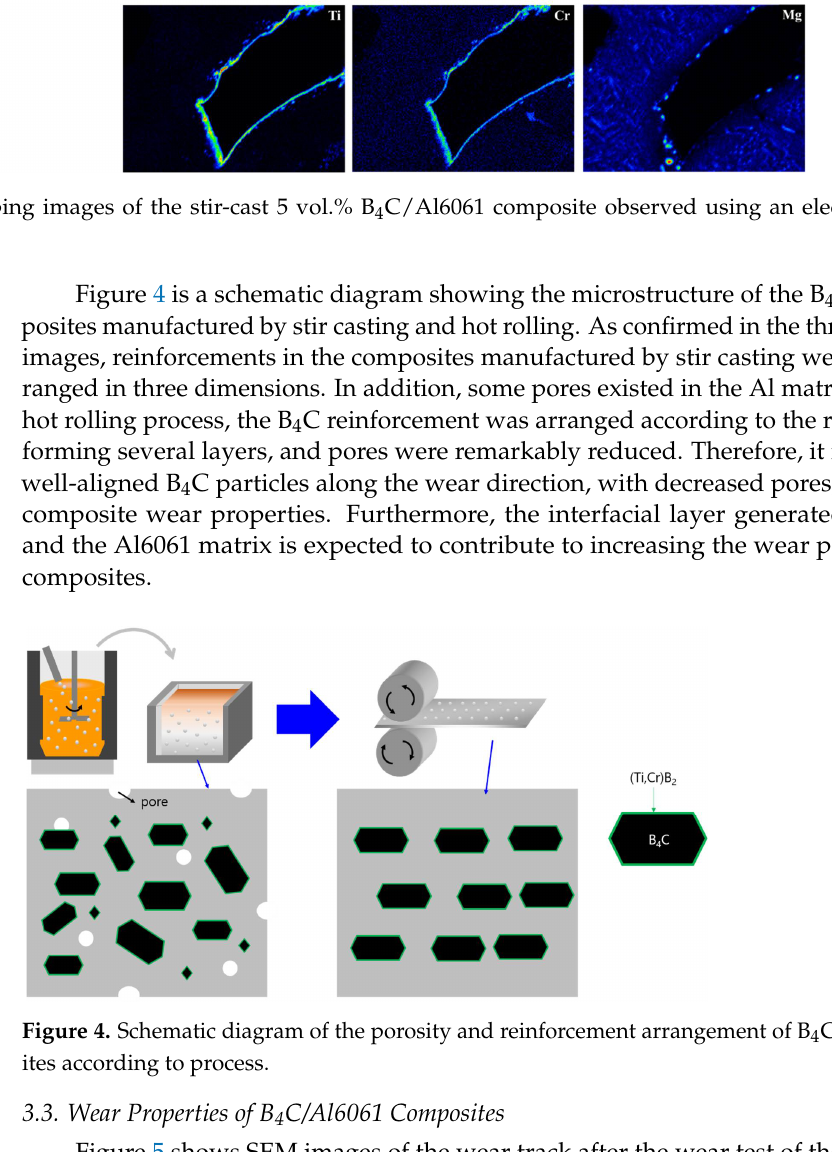
Figure 5. Worn surface SEM images of Al6061, 5 vol.%, 10 vol.%, and 20 vol.% B 4 C/Al6061 composites after wear tests at 5 and 20 N loads.